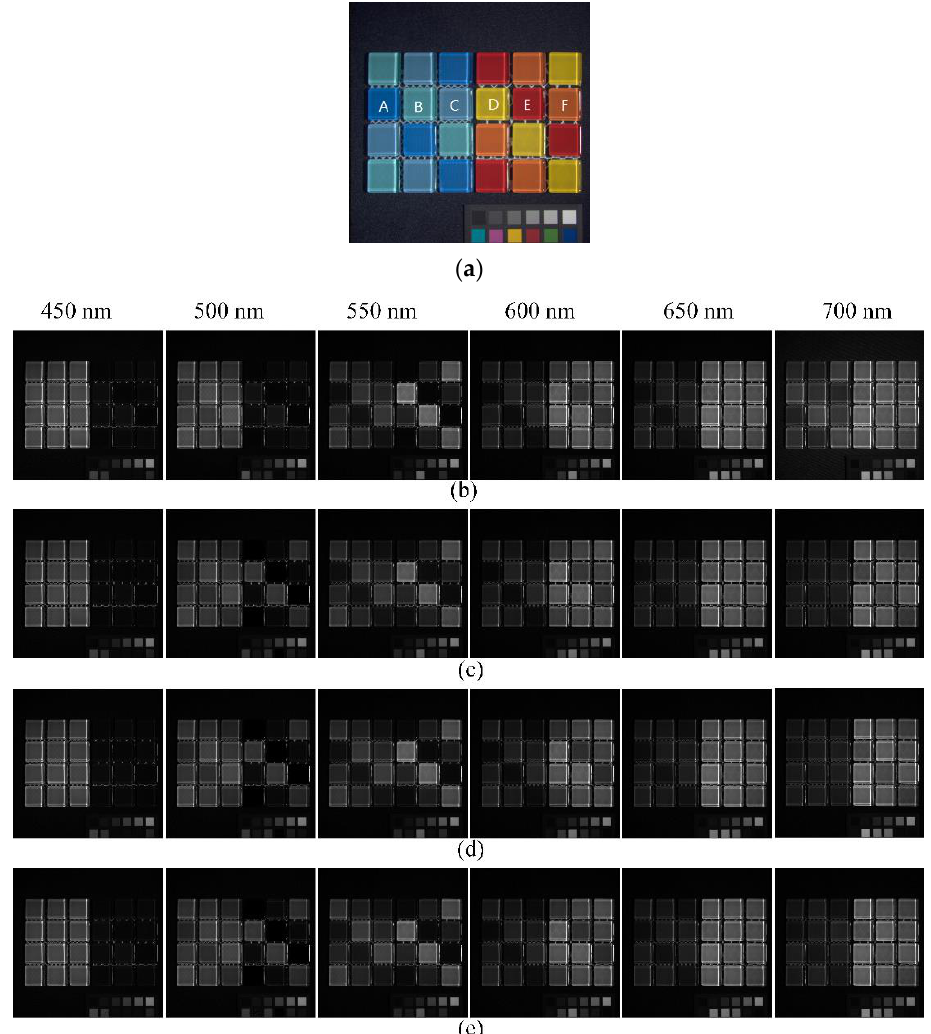
Figure 3. ( a ) Initial image for simulation. ( b – e ) Parts of spectral images at 450, 500, 550, 600, and 650 nm. ( b ) Reference spectral images. ( c ) Recovered images using point-by-point optimization. ( d ) Recovered images using our method, th = 0.1. ( e ) Recovered images using our method, th = 0.5.